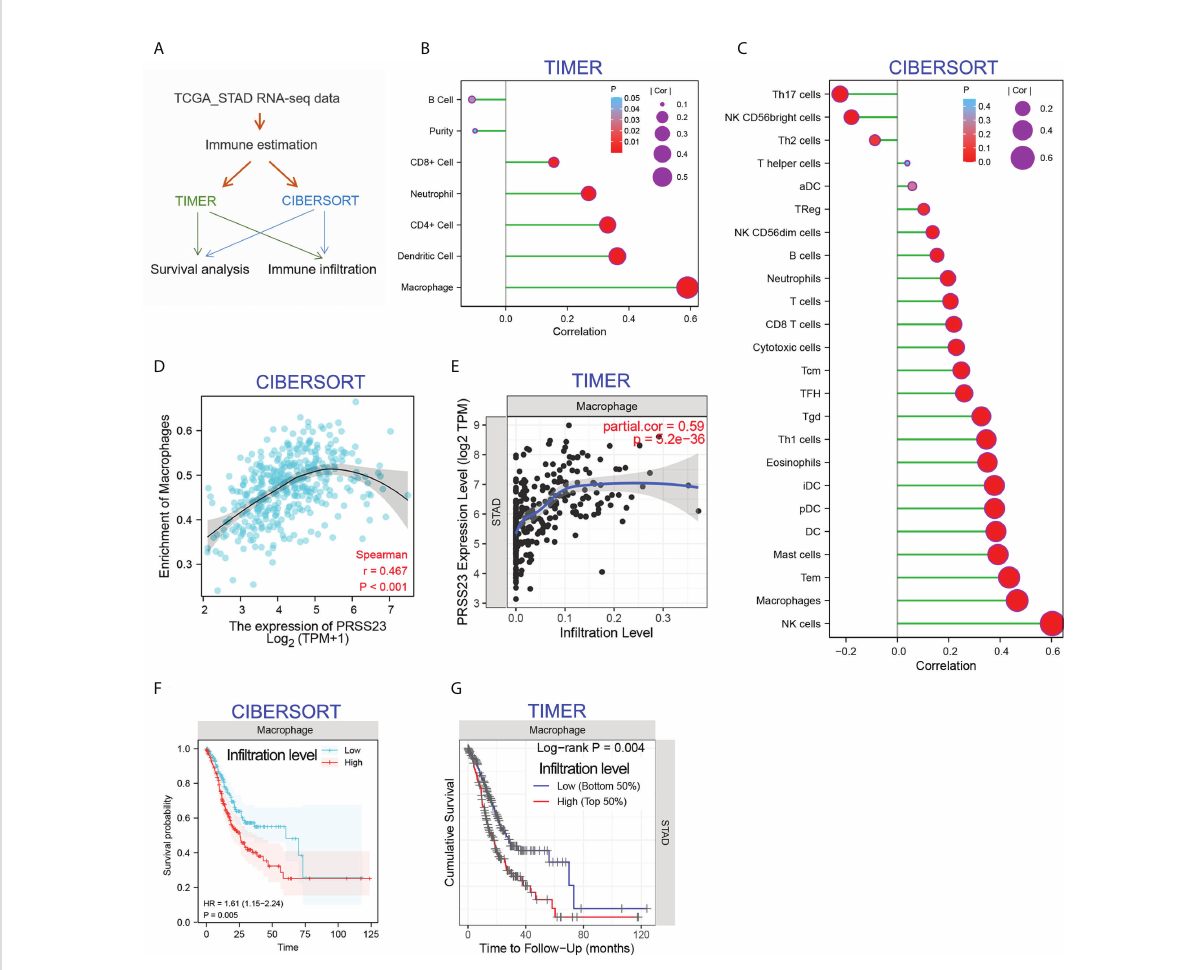
FIGURE 4 PRSS23 is associated with macrophage in fi ltration in GC. (A) Immune estimation analysis was conducted using two different methods. (B, C) The correlation between PRSS23 expression and immune in fi ltration was analyzed using TIMER and CIBERSORT methods. (D, E) The correlation between PRSS23 expression and macrophage in fi ltration was analyzed using TIMER and CIBERSORT methods. (F , G) Survival analysis using CIBERSORT or TIMER indicated that higher level of macrophage in fi ltration predicted poorer prognosis in